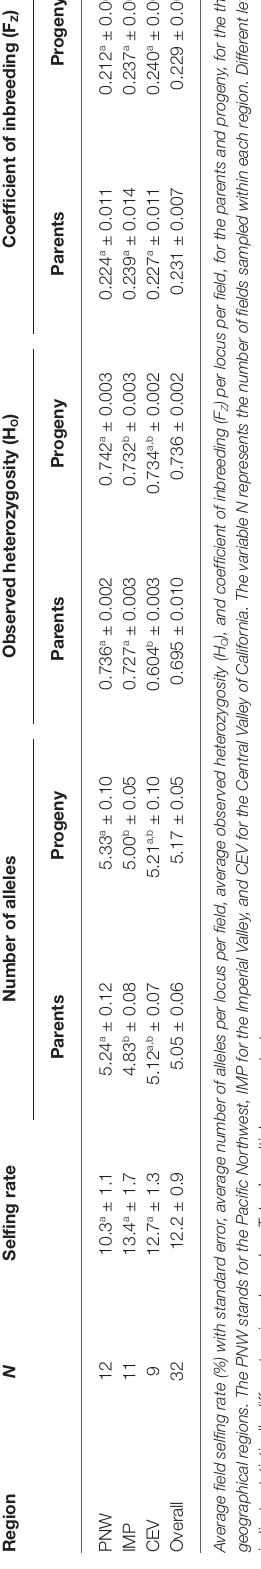
The average coefficient of inbreeding per field did not vary progeny ( F 2,29 = 3.10, p = 0.06; Table 2 ). The parental inbreeding coefficient with a mean of 0.231 ± 0.007 and a range between 0.147 and 0.283 over all fields did not differ statistically from the progeny inbreeding coefficient with a mean of 0.229 ± 0.005 Supplementary Table 2 ). The progeny inbreeding coefficient increased with field selfing rate when the field with the